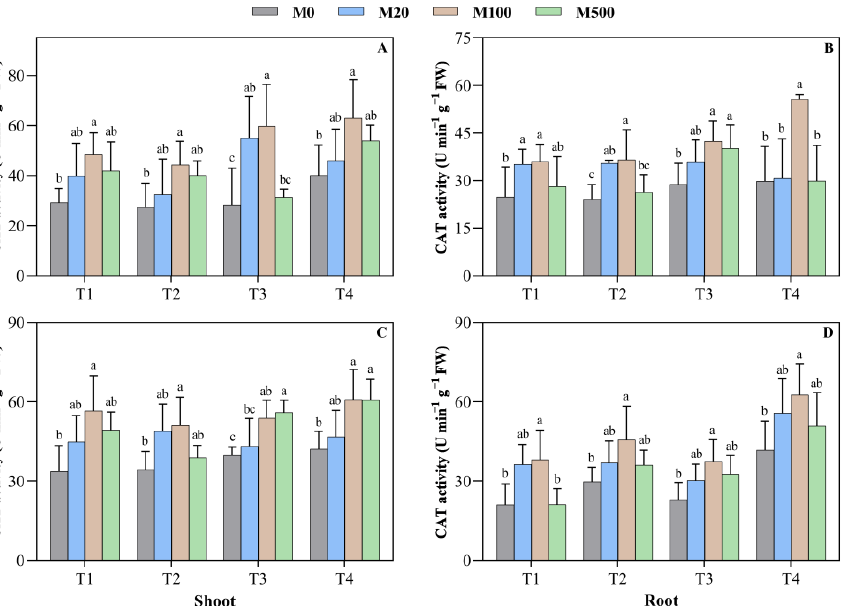
Figure 6. Effects of exogenous melatonin on the catalase (CAT) activity of rice seed germination under high temperature stress. Means ± SEs with different letters in each parameter indicate significant statistical differences ( p < 0.05). ( A ) Catalase (CAT) activity of shoot (7 d); ( B ) catalase (CAT) activity of root (7 d); ( C ) catalase (CAT) activity of shoot (9 d); and ( D ) catalase (CAT) activity of root (9 d).